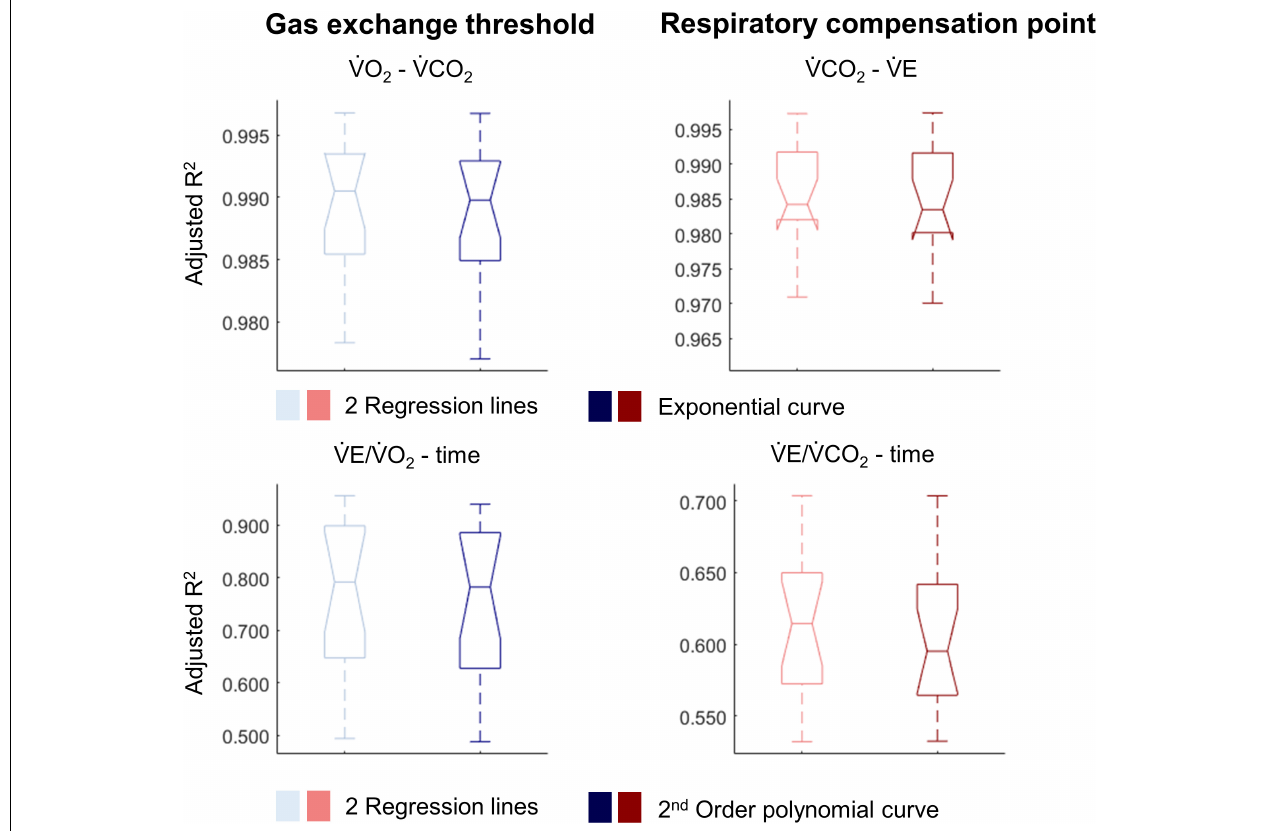
FIGURE 4 | Notched boxplots to compare the adjusted R 2 values of the breakpoint model (i.e., two linear regression lines) vs. the non-breakpoint model (i.e., exponential curve/second-order polynomial) to the respiratory data within the whole cohort of 17 wheelchair athletes. ˙VO 2 , Oxygen uptake; ˙VCO 2 , carbon dioxide production; ˙VE, minute ventilation. Note that the notches extending beyond the 25 th or 75 th percentile indicate that the 95% CI interval ranges exceed the